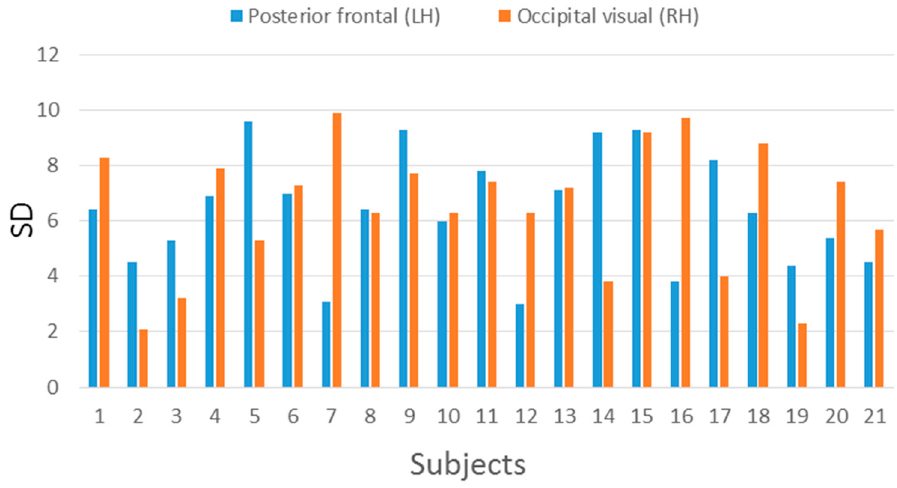
Figure 1. Variability of T2* measurements (indexed by the SD across multiple sampling sites) across participants and regions of interest.